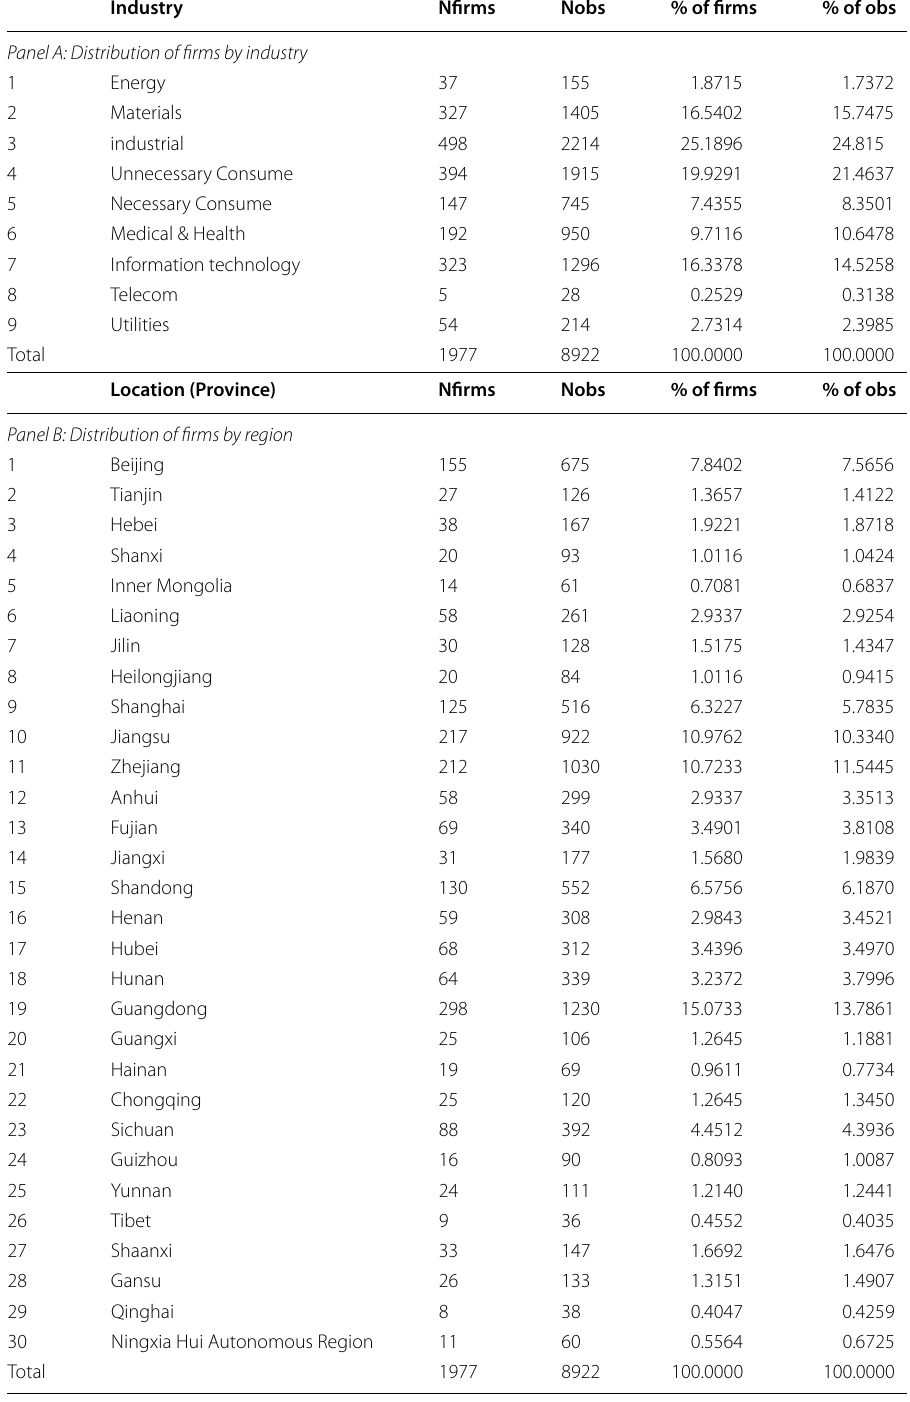
Table 2 Distribution of firms by industry and